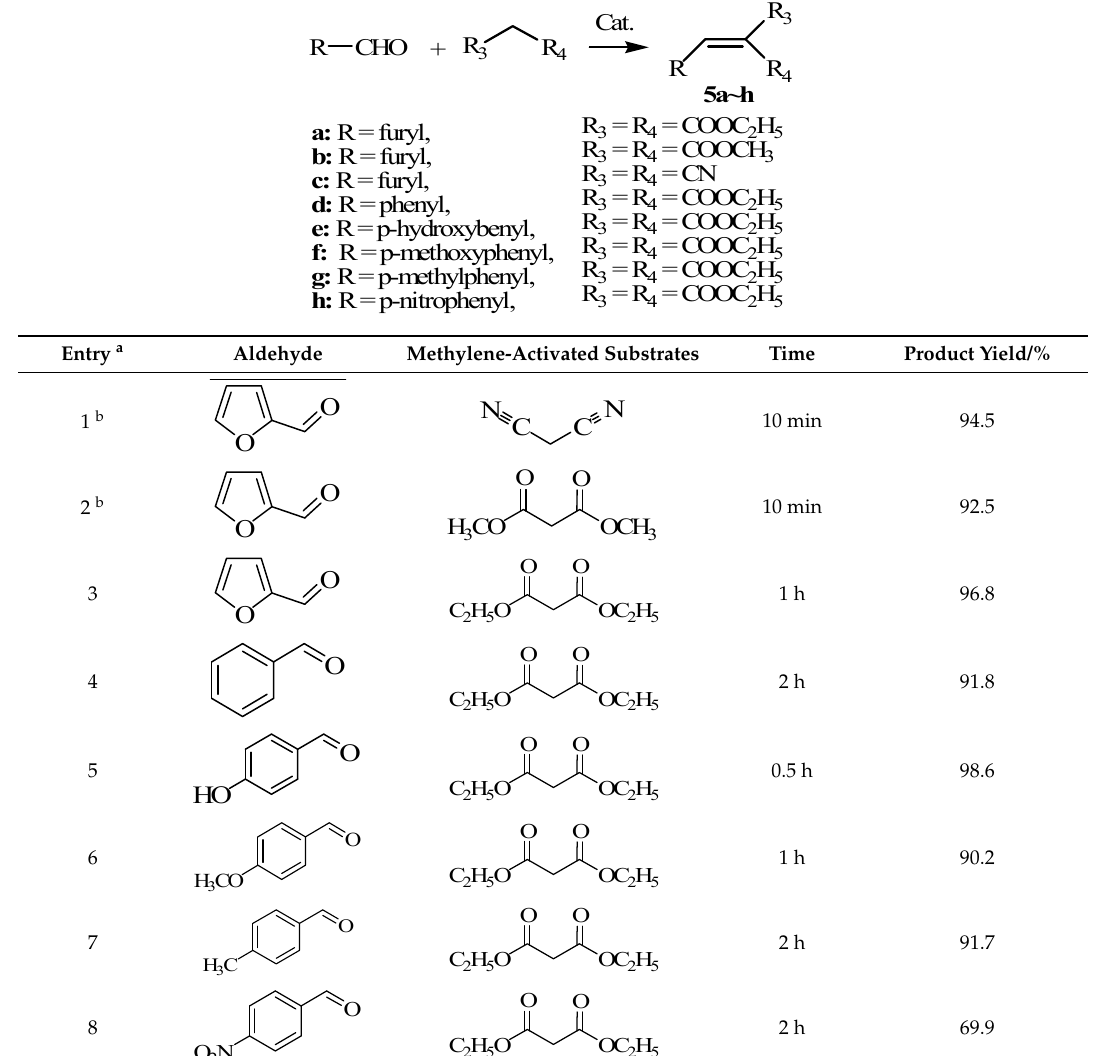
Table 4. Knoevenagel condensation of aromatic/heterocyclic aldehydes with methylene-activated substrates catalyzed by 3-pyrrolidinamine.